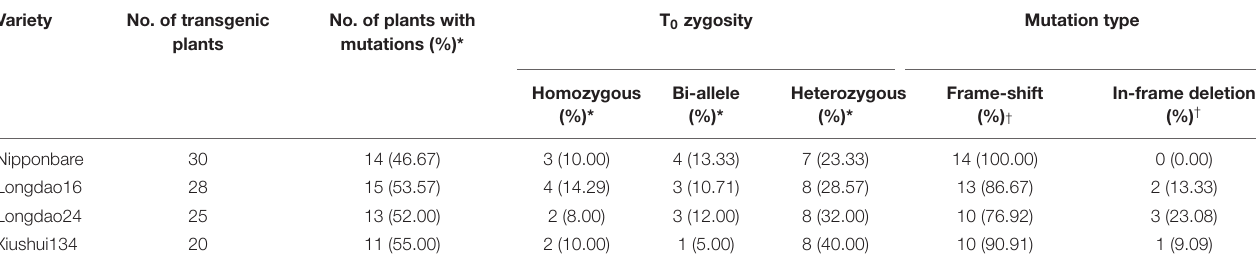
TABLE 1 | Mutation analysis of T 0 plants transformed with the sgRNA-Cas9 construct targeting the first exon of the Ehd1 gene. Variety No. of transgenic No. of plants with plants mutations (%)*